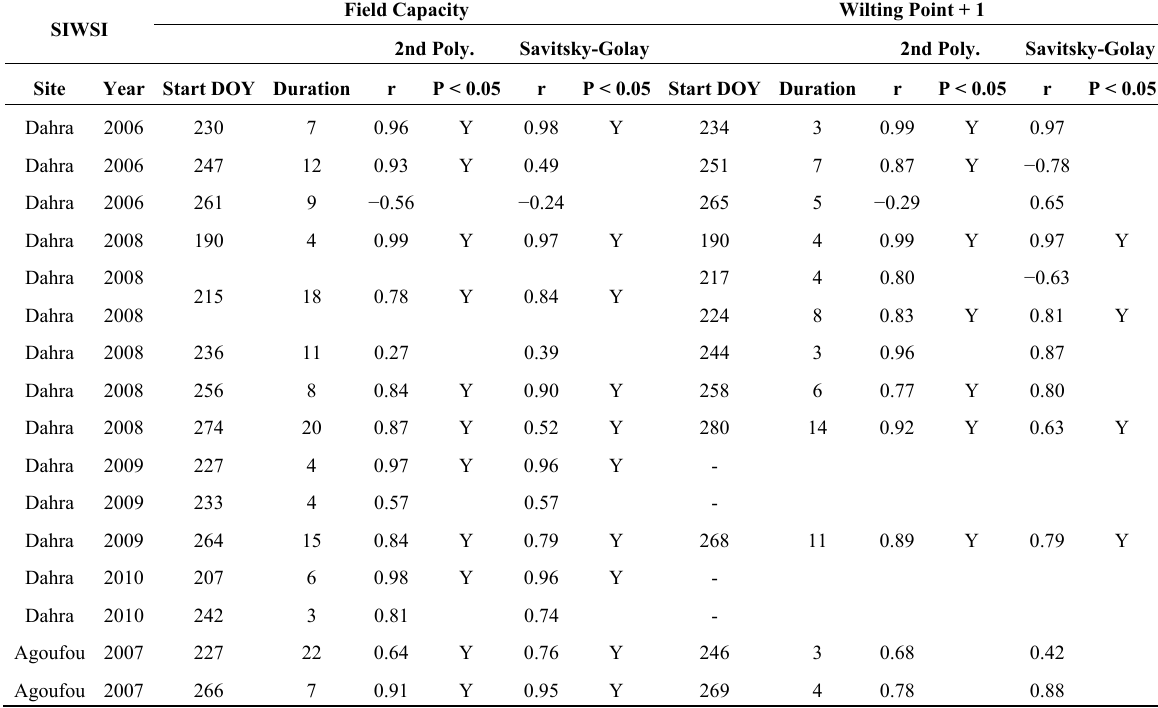
Table 5. Overview of Shortwave Infrared Water Stress Index (SIWSI) anomalies and events when low plant available water was observed. Correlation coefficients (r) between number of days after Soil Moisture Content (SMC) dropped below threshold, either Wilting point ( WP) + 1 or Field Capacity (FC) (vol.%), and SIWSI anomalies are noted, and p-Values have been calculated based on r and duration in days and marked with Y if p < 0.05. Only events of at least three days duration are included. SIWSI